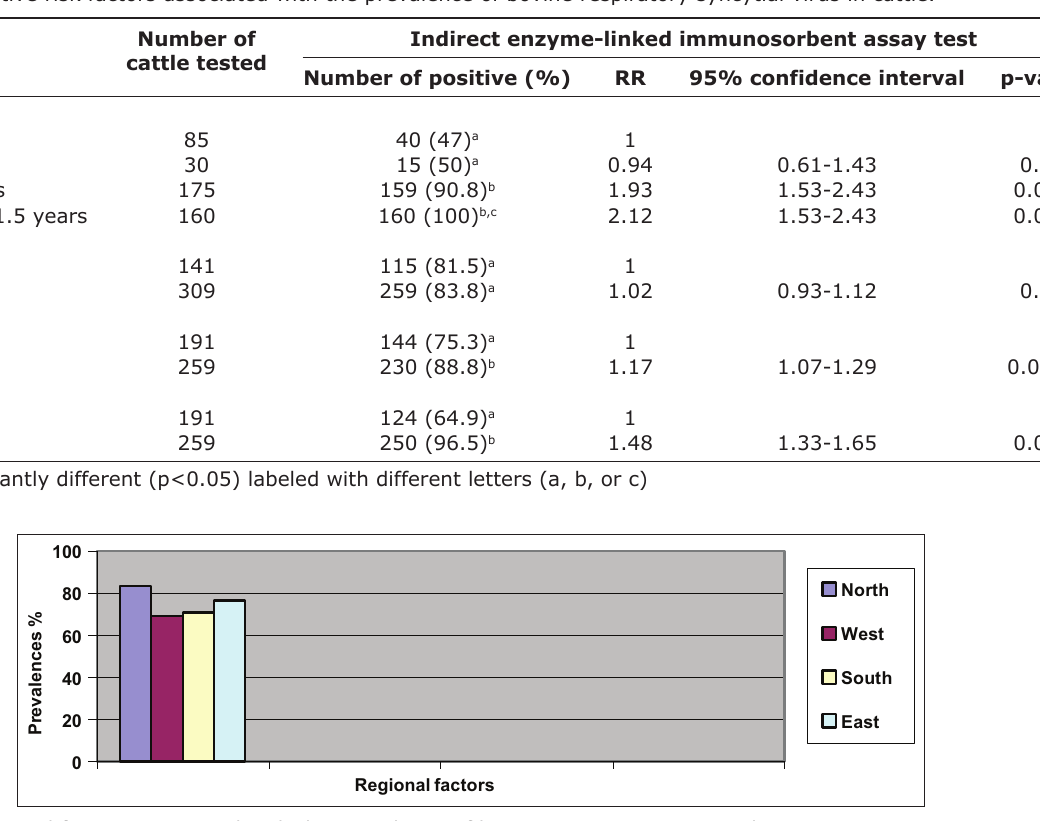
Figure-1: Regional factors associated with the prevalence of bovine respiratory syncytial virus.